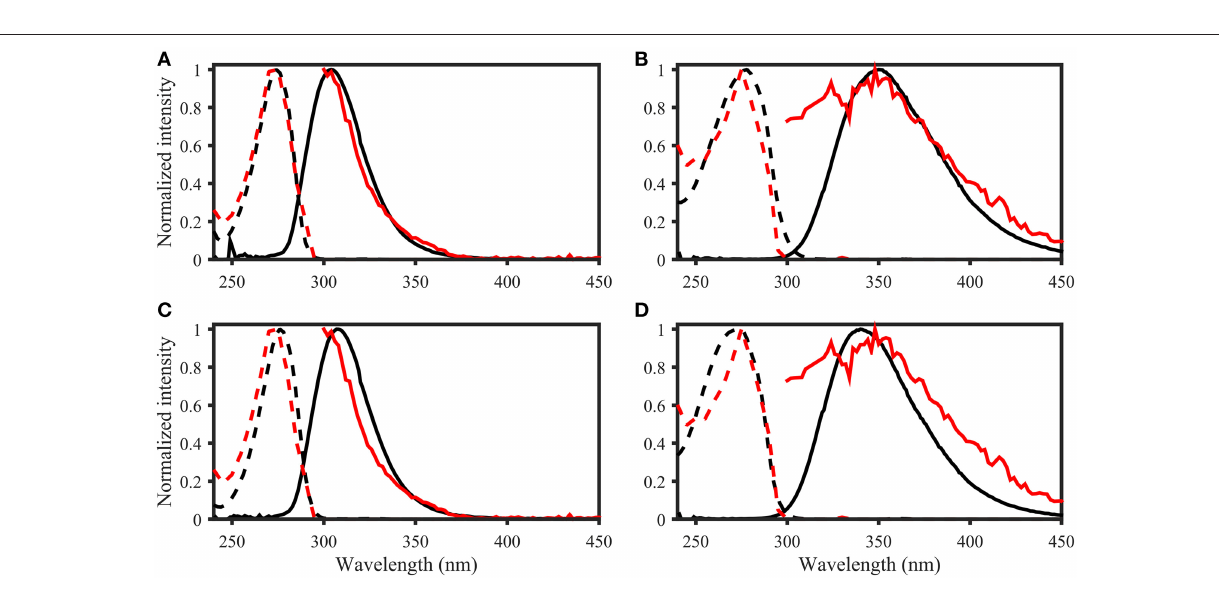
FIGURE 8 | OpenFluor matches of (A) tyrosine, (B) tryptophan, (C) p-cresol, and (D) indole (all in black) with PARAFAC components (all in red) from Kowalczuk et al. (2013). Dashed lines represent excitation loadings, solid lines show emission loadings. Tryptophan and indole, as well as tyrosine and p-cresol yield matches with the same PARAFAC